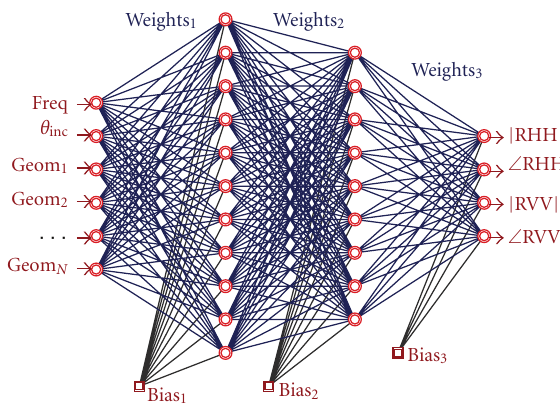
Figure 2: A typical multilayered perceptron structure, with 6 input and 4 output neurons and 2 hidden layers of 11 and 9 neurons, respectively.